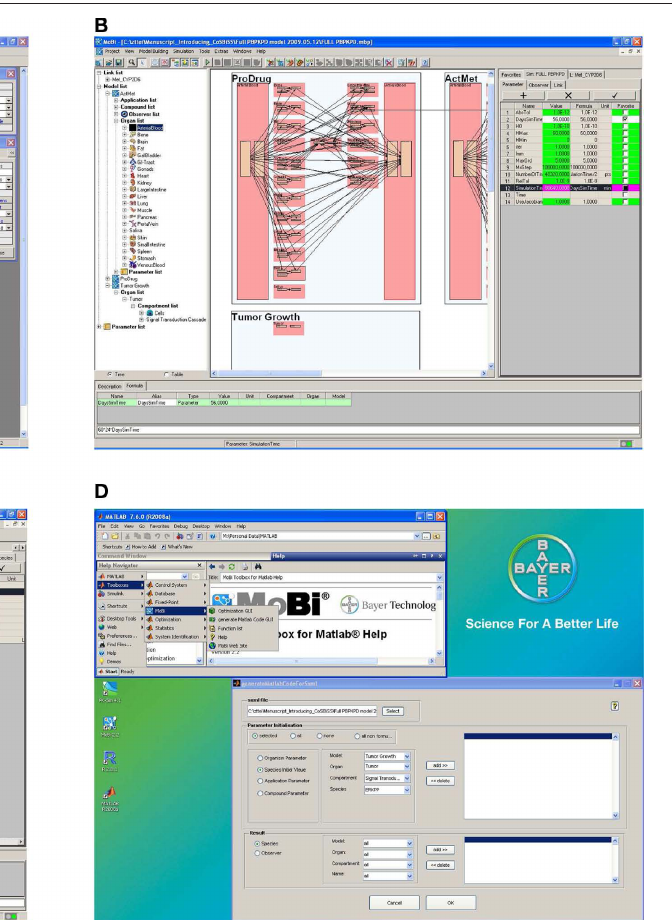
Figure 3 | graphical user interface examples. The software is build to allow an efficient building, processing, and analysis of computational systems biology models. While assisting the user through graphical interfaces, full programming flexibility is provided through the interfaces to R and MATLAB ® . (A) PK-Sim ® screenshot. (B) MoBi ® screenshot at